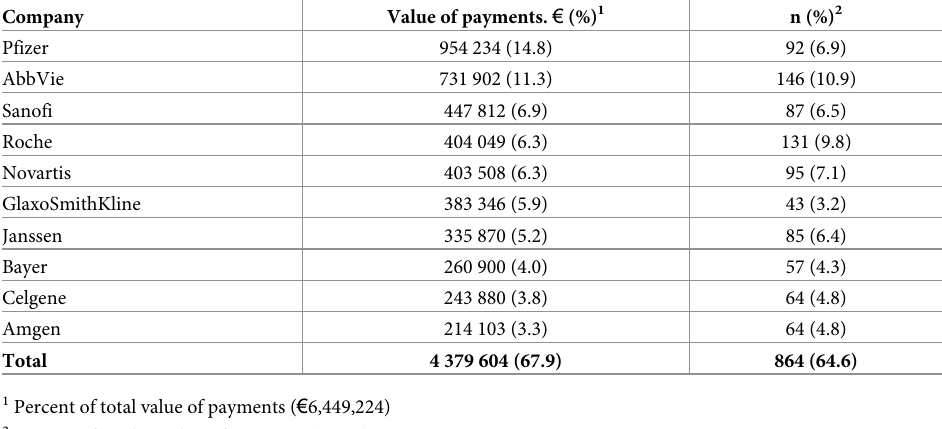
Table 2. Top ten drug companies reporting payments to patient organisations in Sweden (2014–18).